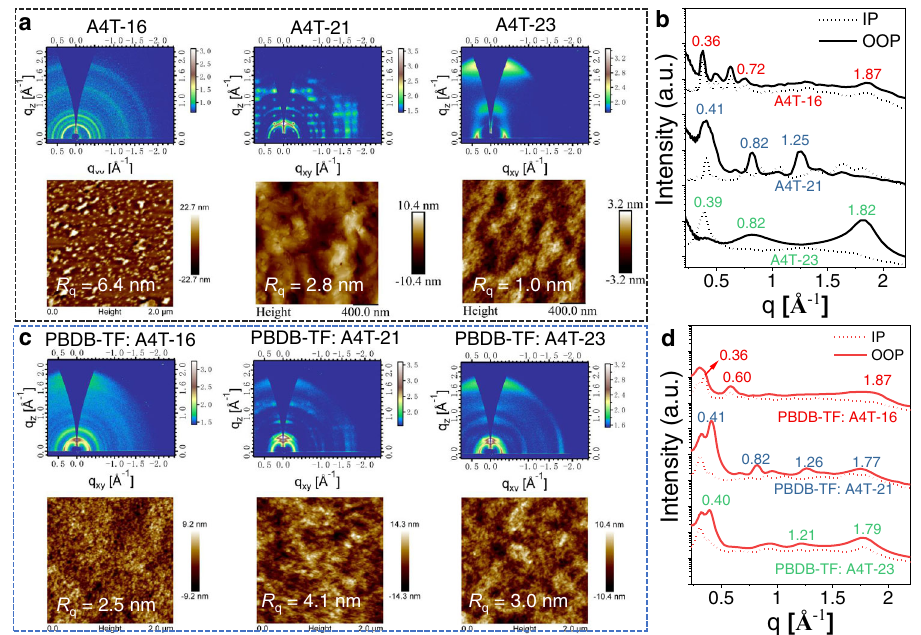
Fig. 6 GIWAXS and AFM analysis of the blend fi lms. a GIWAXS patterns and AFM height images, b the IP, OOP extracted line-cut pro fi les of the A4T-16-, A4T-21- A4T-23- pure fi lms, c GIWAXS patterns and AFM height images, d the IP, OOP extracted line-cut pro fi les of the PBDB-TF: A4T-16-, PBDB-TF: A4T- 21-, PBDB-TF: A4T-23- blend fi lms.